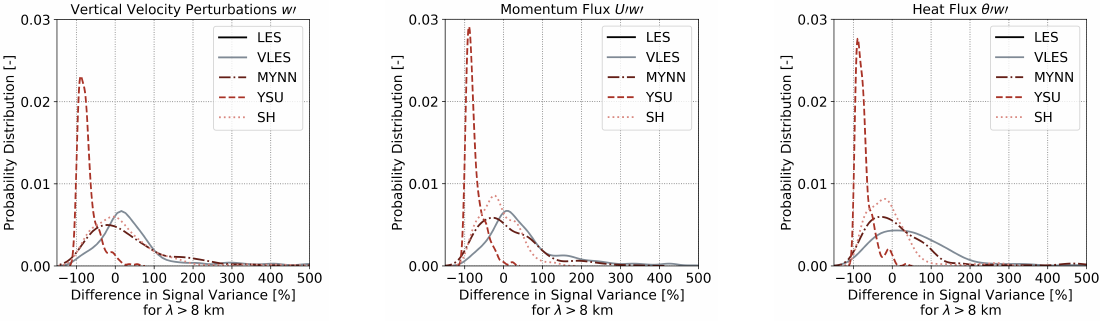
Figure 13. Curve-fitted histogram for time series of errors (%) in energy (co)spectra, at z / z i = 0.5, integrated for λ ≥ 8 km and shown for vertical velocity perturbations, w (cid:48) ; momentum flux, U (cid:48) w (cid:48) ; and heat flux, θ (cid:48) w (cid:48)